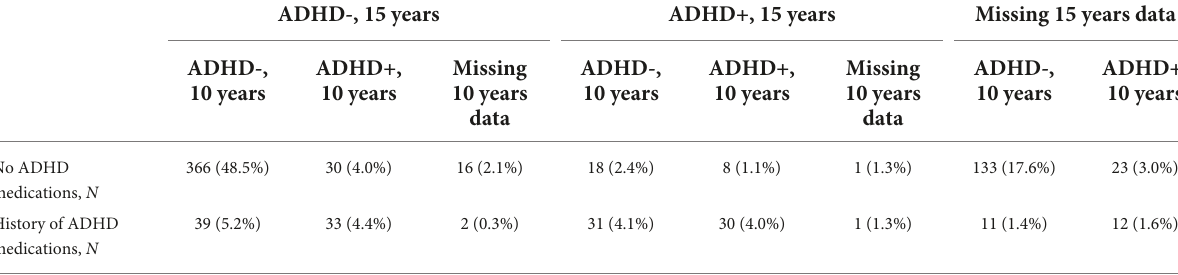
TABLE 2 Characterization of ADHD outcomes and medication status in sample used for analysis.